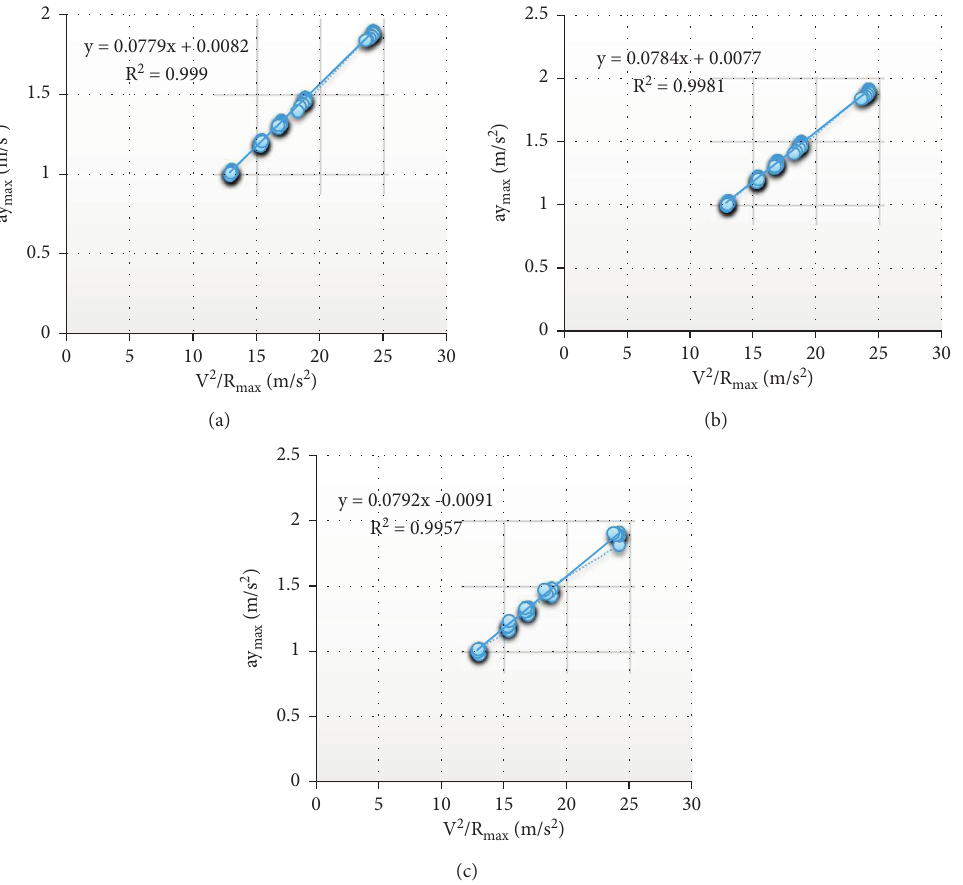
Figure 31: Maximum lateral acceleration in the spiral horizontal curve. (a) Sedan. (b) SUV. (c)